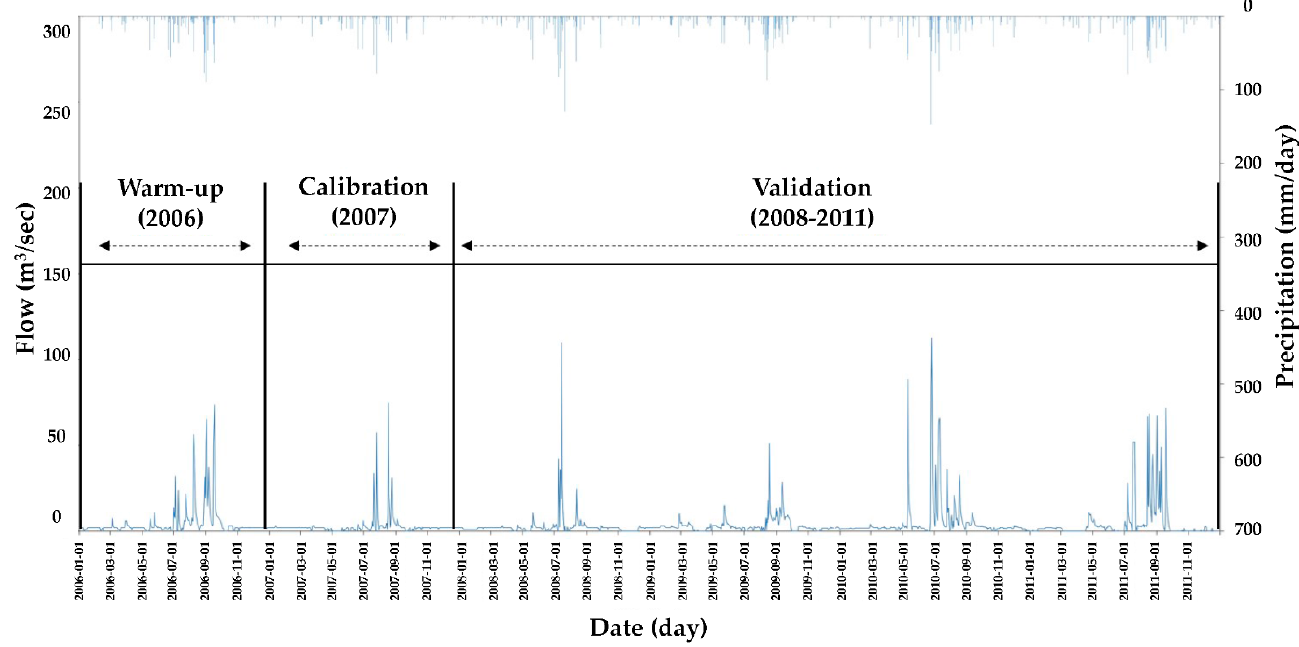
Figure 7. Selection of periods for parameter calibration and validation based on the daily discharge of the Yecheon watershed from 1 January 2006 to 31 December 2011.